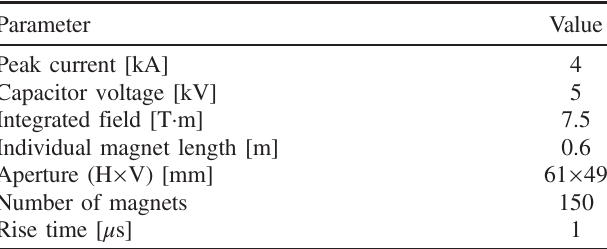
TABLE II. Extraction kickermagnet parametersfor50